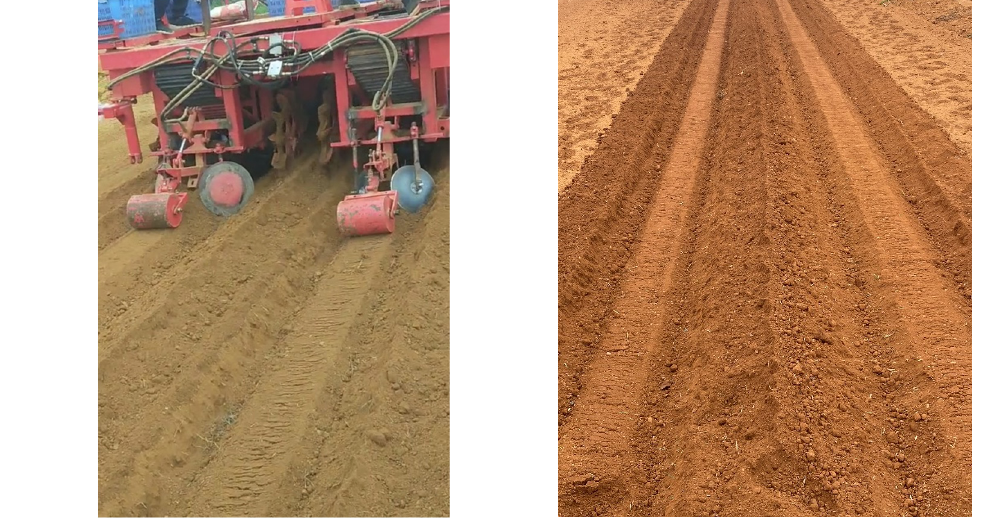
Table 4. The results of the quadratic orthogonal rotation regression test. Site Number